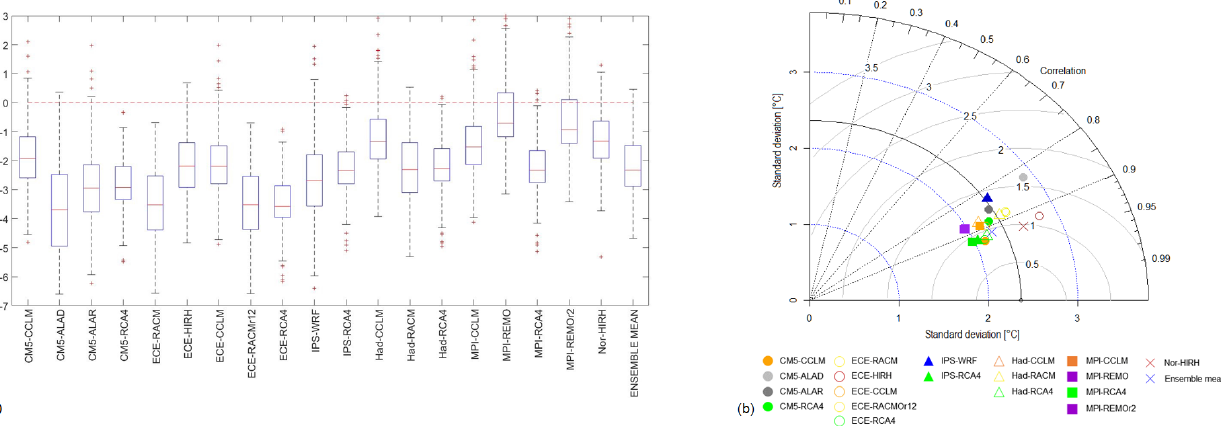
Figure 2. (a) Box plots representing the frequency distribution of RCM errors in mean annual temperature for the whole study area. (b) Taylor diagram comparing model performances in reproducing the inter-annual variability of mean temperature for the whole study area.